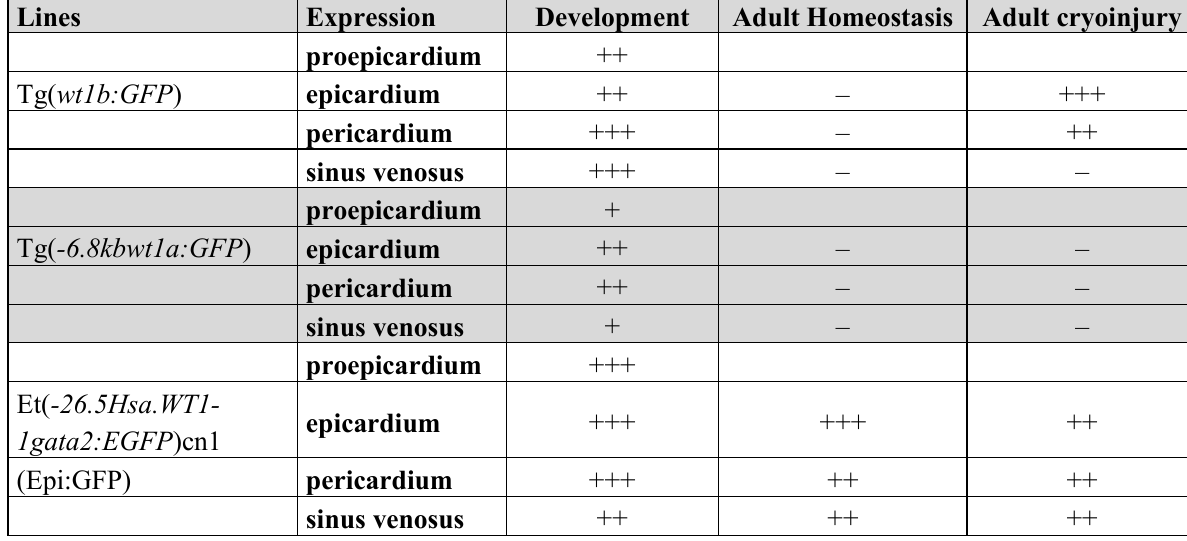
Table 1. Summary of the GFP expression patterns of Tg( wt1b:GFP ), Tg( -6.8kbwt1a:GFP ) and Epi:GFP in the embryonic epicardium, during adult homeostasis and in response to cardiac injury. For development, expression between 48 to 96 hpf was considered. Adult homeostasis corresponds to 6–12-month-old animals grown at standard density, and cryoinjury corresponds to expression observed in similar adults at three days post-injury (3 dpi). Degree of expression ranges from +++ (very strong) to – (not expressed or very faint